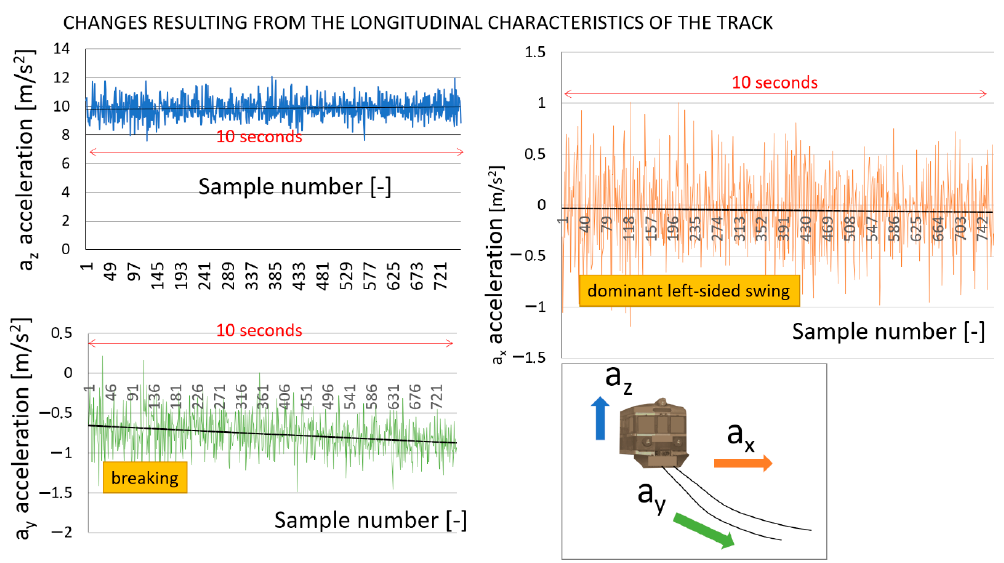
Figure 5. Visualization of the example data from the output file containing linear accelerations. EN 57 sample run in a straight section of the station track. Source: authors’ own materials.